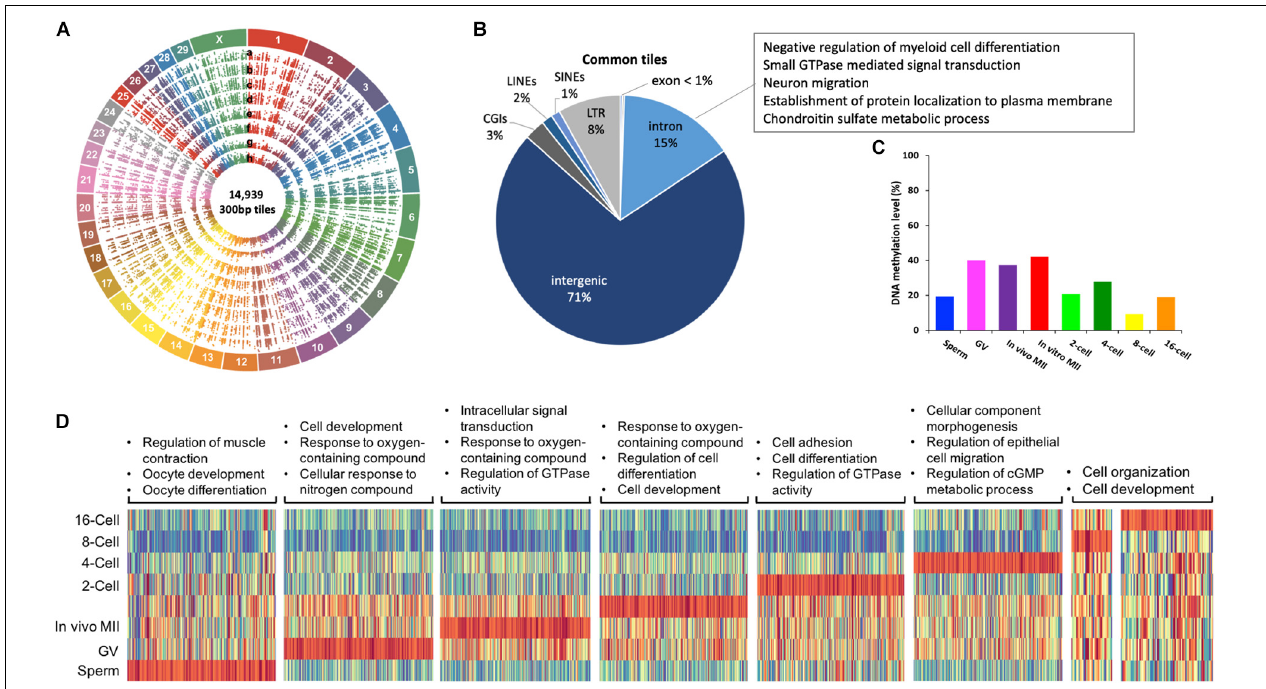
FIGURE 3 | Commonly methylated regions in bovine gametes and pre-implantation embryos. Circos plot (A) visualization of 14,939 commonly methylated 300-bp tiles among all samples. a. sperm, b. GV, c. in vivo MII, d. in vitro MII, e. 2-cell, f. 4-cell, g. 8-cell, h. 16-cell. Pie plot (B) of the distribution of commonly methylated tiles in genomic regions and their associated GO term representatives. Bar plot (C) of averaged DNA methylation levels of commonly methylated tiles across stages. Heatmap (D) of enrichment of hypermethylated regions in each stage and associated GO term representatives. GV: germinal vesicle oocytes; MII: matured oocytes. Green: hypomethylation, red: